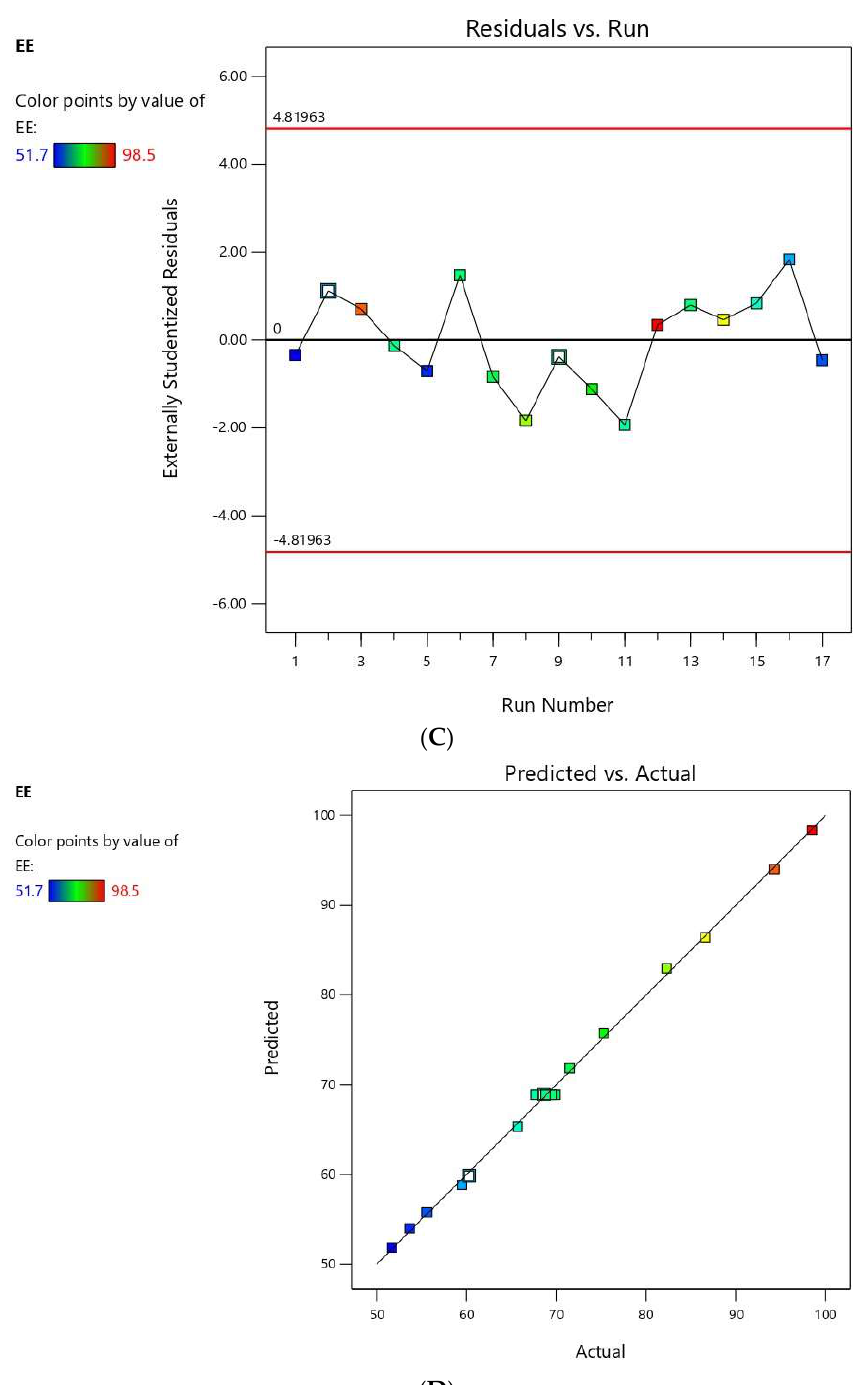
Figure 2. Diagnostic plots for entrapment efficiency of FLB niosomes ( A ); normal probability plot ( B ); studentized residuals vs. predicted values plot ( C ); externally studentized residuals vs. run number plot; and ( D ) predicted vs. actual values plot.